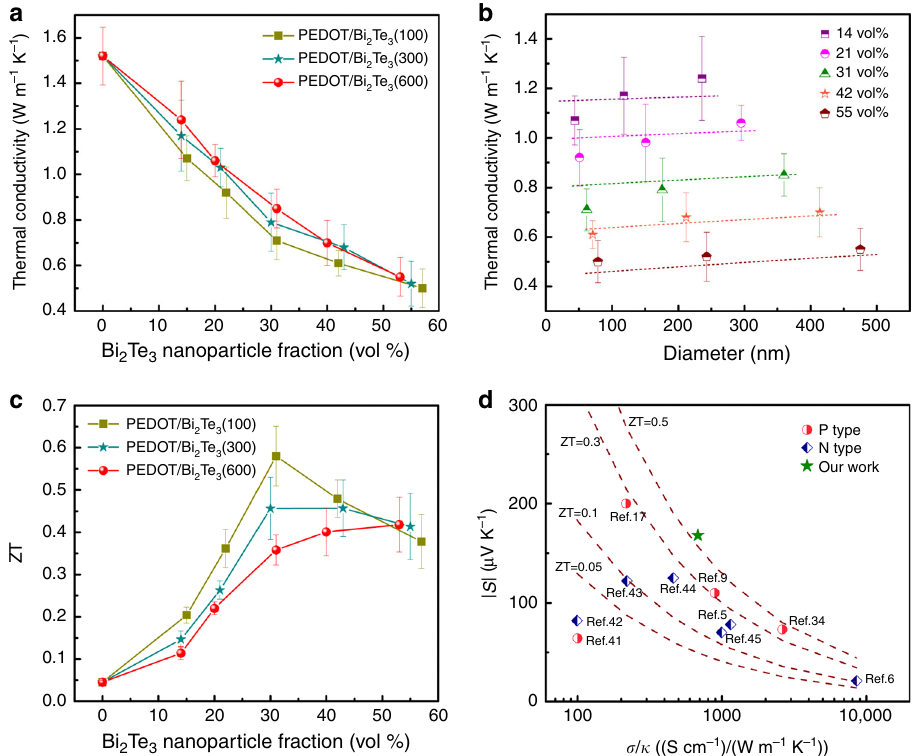
Fig. 4 In-plane thermal conductivity and ZT value. a Thermal conductivity of PEDOT/Bi 2 Te 3 hybrid fi lms as a function of Bi 2 Te 3 nanoparticle fraction. Each point shows the standard deviations from three independent measurements. b Thermal conductivity of PEDOT/Bi 2 Te 3 hybrid fi lms as a function of the diameter of Bi 2 Te 3 nanoparticles. The dash lines are the fi tting lines based on Eq. (5) under a given Bi 2 Te 3 nanoparticle fraction. c ZT value of PEDOT/ Bi 2 Te 3 hybrid fi lms as a function of Bi 2 Te 3 nanoparticle fraction. d Comparison of the thermoelectric properties around room temperature between this work and the state-of-the-art organic materials and organic − inorganic composite materials, including conducting polymers 17, 34 , conducting polymer- inorganic composites 9 , chemically doped single-walled carbon nanotubes 41, 42 , metal coordination polymers 43, 44 , organic intercalated transition metal dichalcogenides 5 , insulating polymer-metal composites 6 , and organic − inorganic hybrid perovskites 45